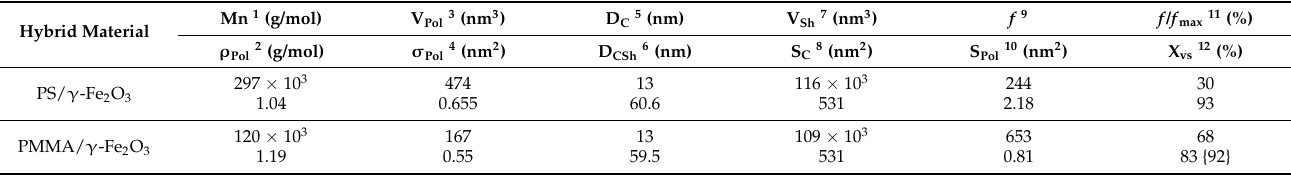
Table A2. Characteristics of the hybrid materials in dry and swollen